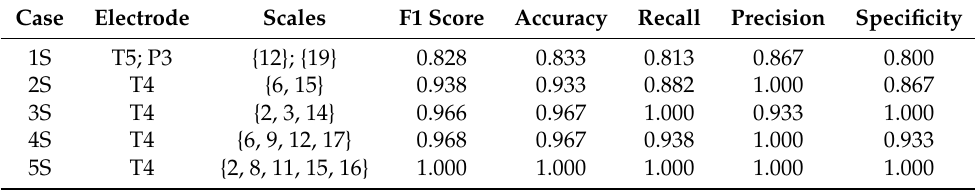
Table 2. Optimal F1 score and corresponding accuracy, precision, recall, specificity, selected electrode, and scales for each of the 1S–5S cases,